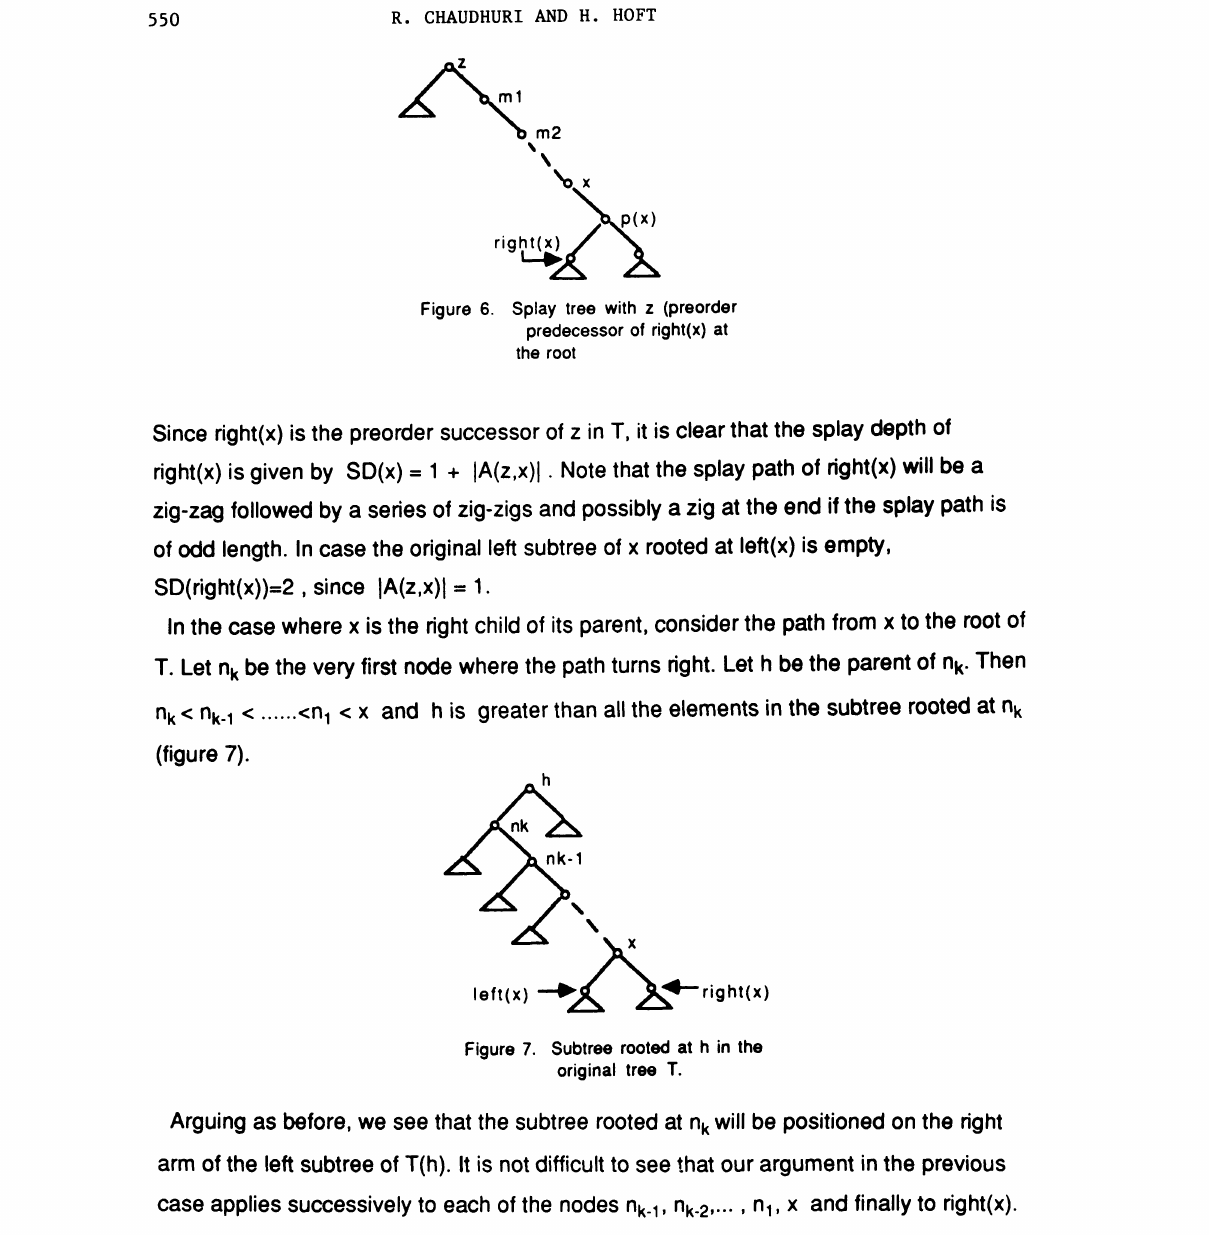
n x and finally to 1,